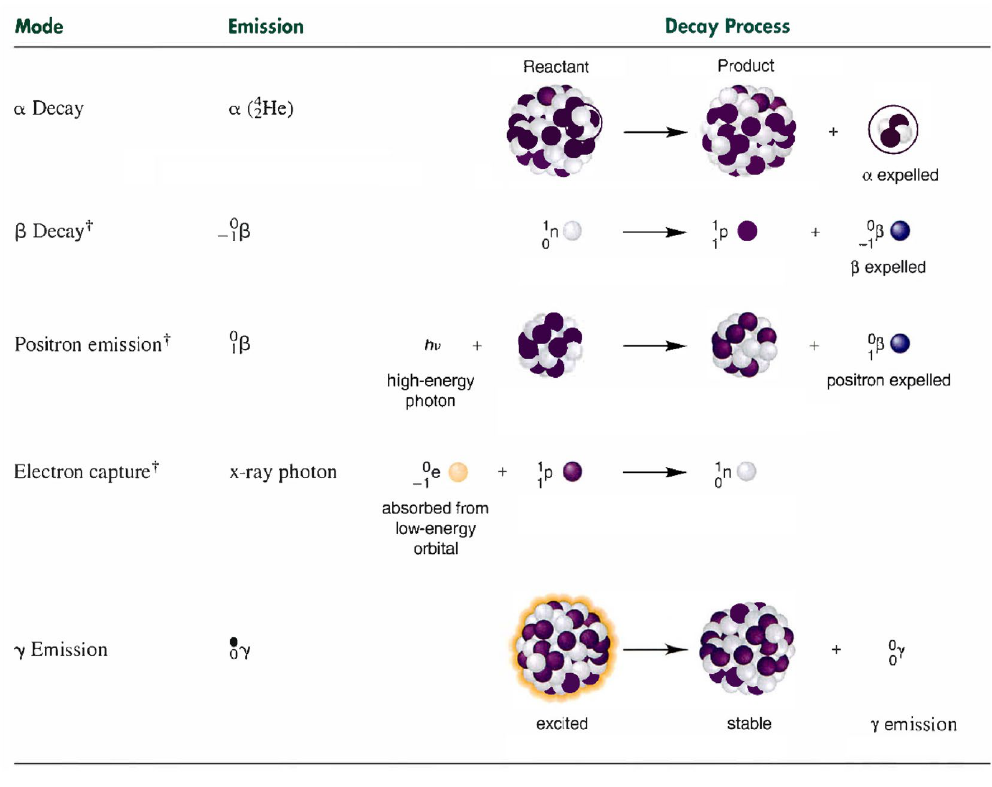
Figure 2. Different modes of decay 62